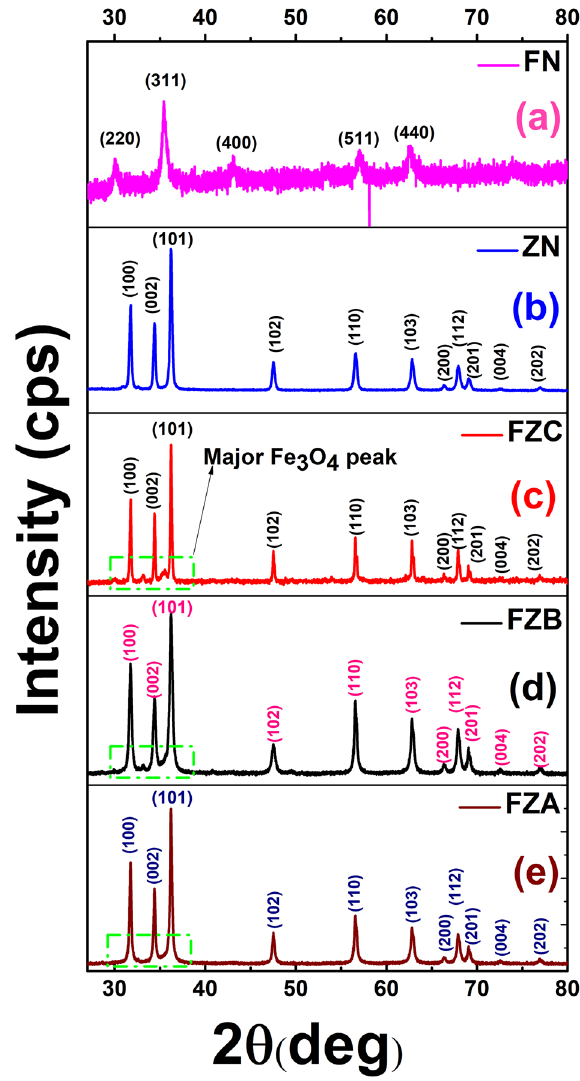
Figure 2. XRD pattern of the FZNC samples ( a ) Fe 3 O 4 , ( b ) bare ZnO, ( c ) FZC, ( d ) FZB, ( e )